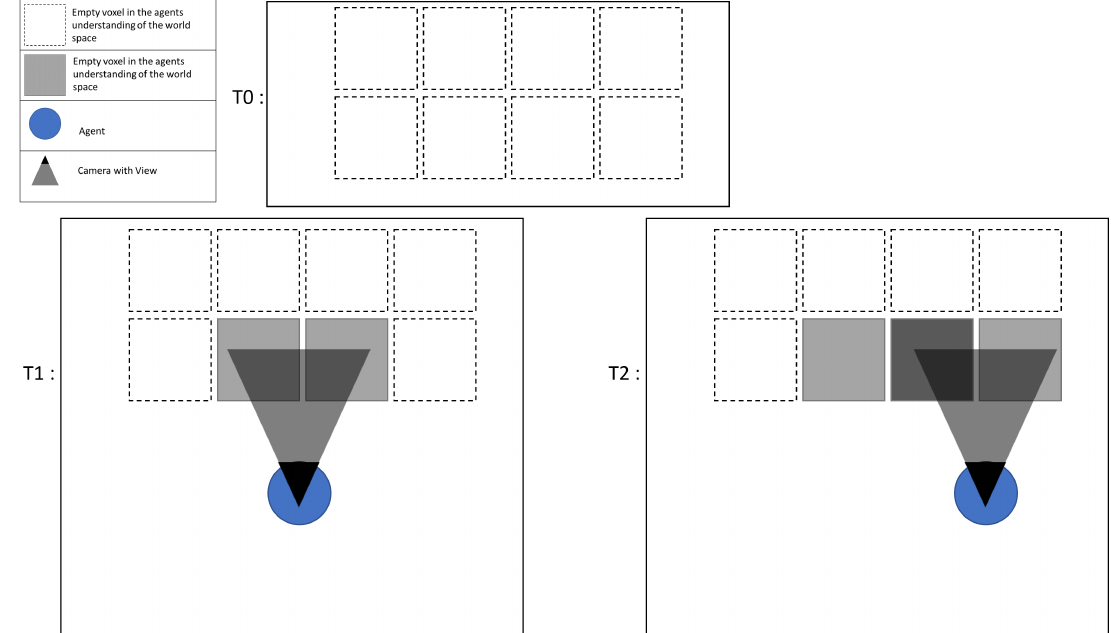
Figure 4. Figure showing object overlay increasing the probability of a voxel containing an